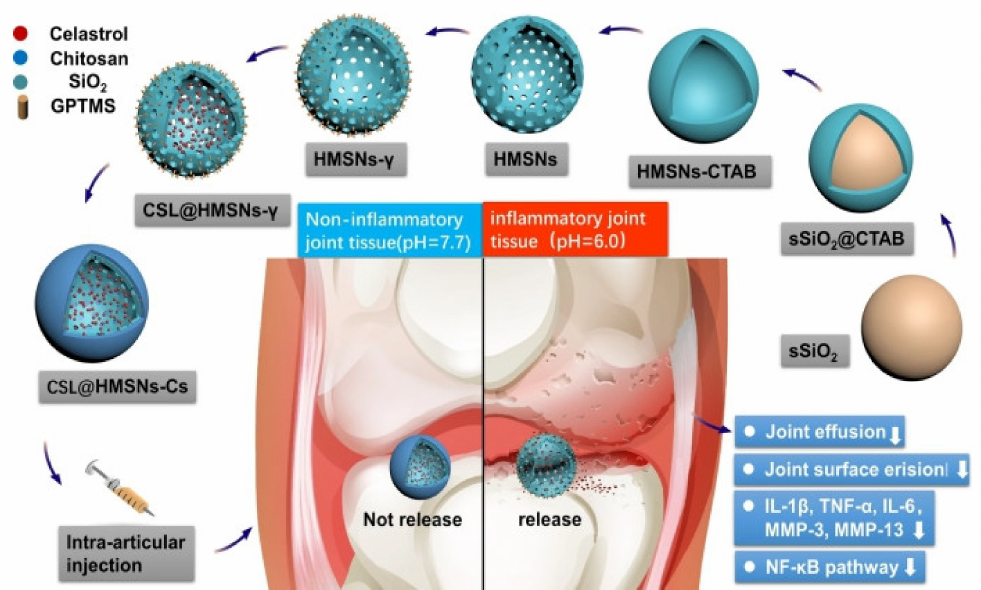
Figure 3. The process during which celastrol-loaded hollow mesoporous silica nanoparticles capping with chitosan (CSL@HMSNs-Cs) are synthesized, injected, released at a specific pH, and their effec- tiveness. Reprinted with permission from Jin et al, J. Nanobiotechnol., published by Springer